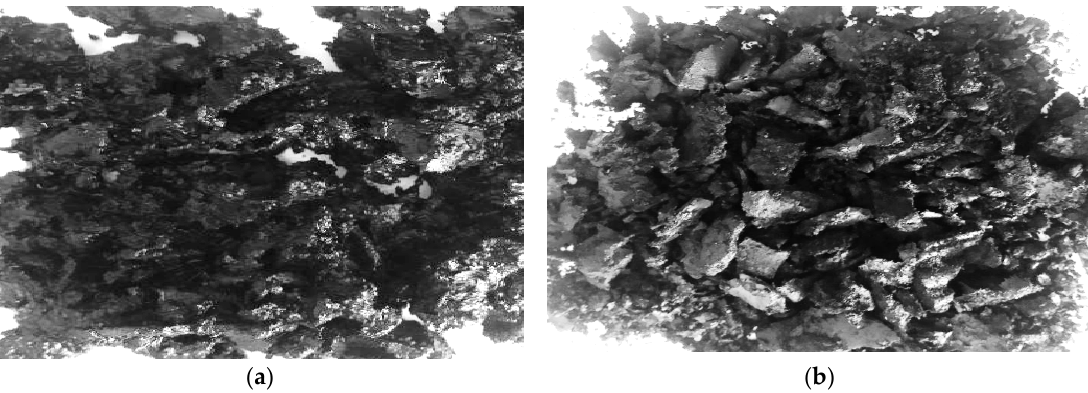
Figure 4. Devulcanized rubber samples in autoclaves. ( a ) devulcanized rubber sample in the autoclave by classic technology; and, ( b ) devulcanized rubber sample in autoclave with vacuuming the autoclave.